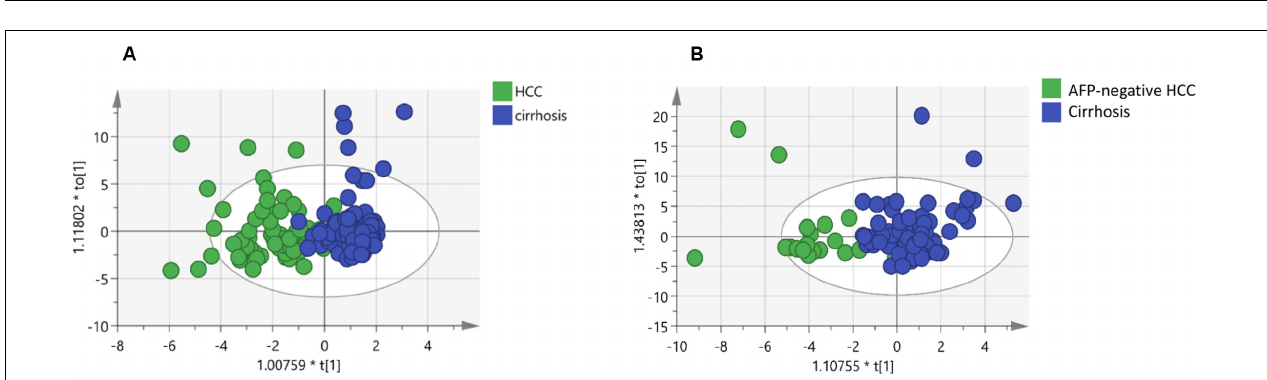
FIGURE 2 | Comparison of serum sphingolipid levels (only the serum sphingolipids with significant difference are shown). (A) Twenty-four sphingolipid metabolites were significantly different between HCC ( n = 72) and cirrhotic patients ( n = 104). (B) Sixteen sphingolipid metabolites were significantly different between AFP-negative HCC ( n = 24) and cirrhotic patients ( n = 104). Data are expressed as median (range) (* P < 0.05, ** P < 0.01, Mann–Whitney U test).